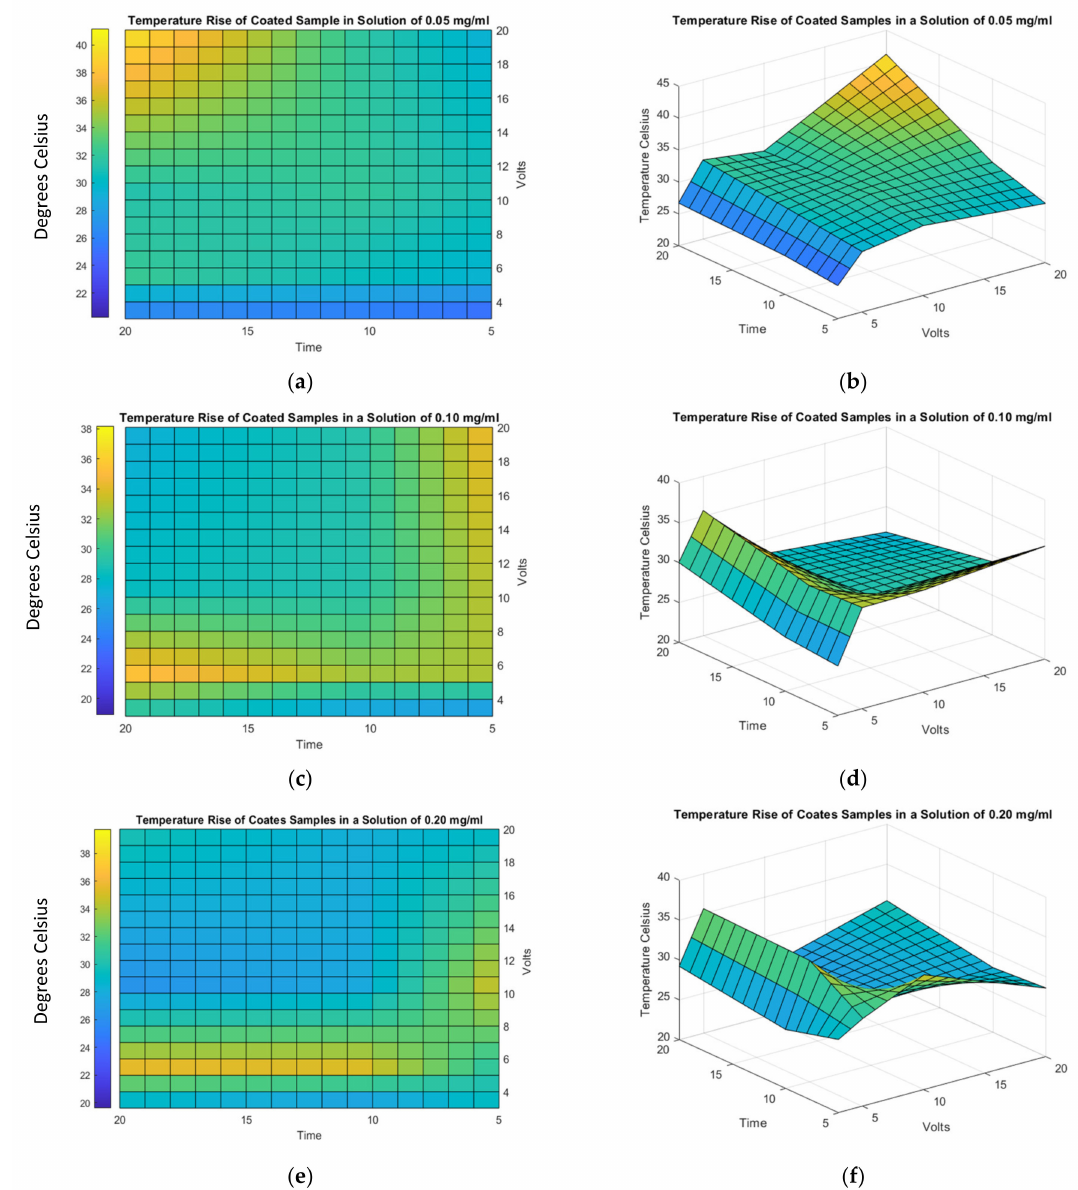
Figure 9. Surface temperature rise for di ff erent MWCNTs concentration solutions. ( a ) Top view and ( b ) schematic view of the surface temperature rise for metallic samples coated in a solution of 0.05 mg / mL MWCNT. ( c ) Top view and ( d ) schematic view of the surface temperature rise for metallic samples coated in a solution of 0.10 mg / mL MWCNT. ( e ) Top view and ( f ) schematic view of the surface temperature rise for metallic samples coated in a solution of 0.20 mg / mL MWCNT. Experimental results show that surface thermal dissipation of the coated Al6061 samples improves linearly for small voltage and short deposition time when low MWCNT concentrations are used. However, for higher MWCNT concentration solutions, the surface thermal dissipation is enhanced when thicker MWCNT layers are deposited over the metallic